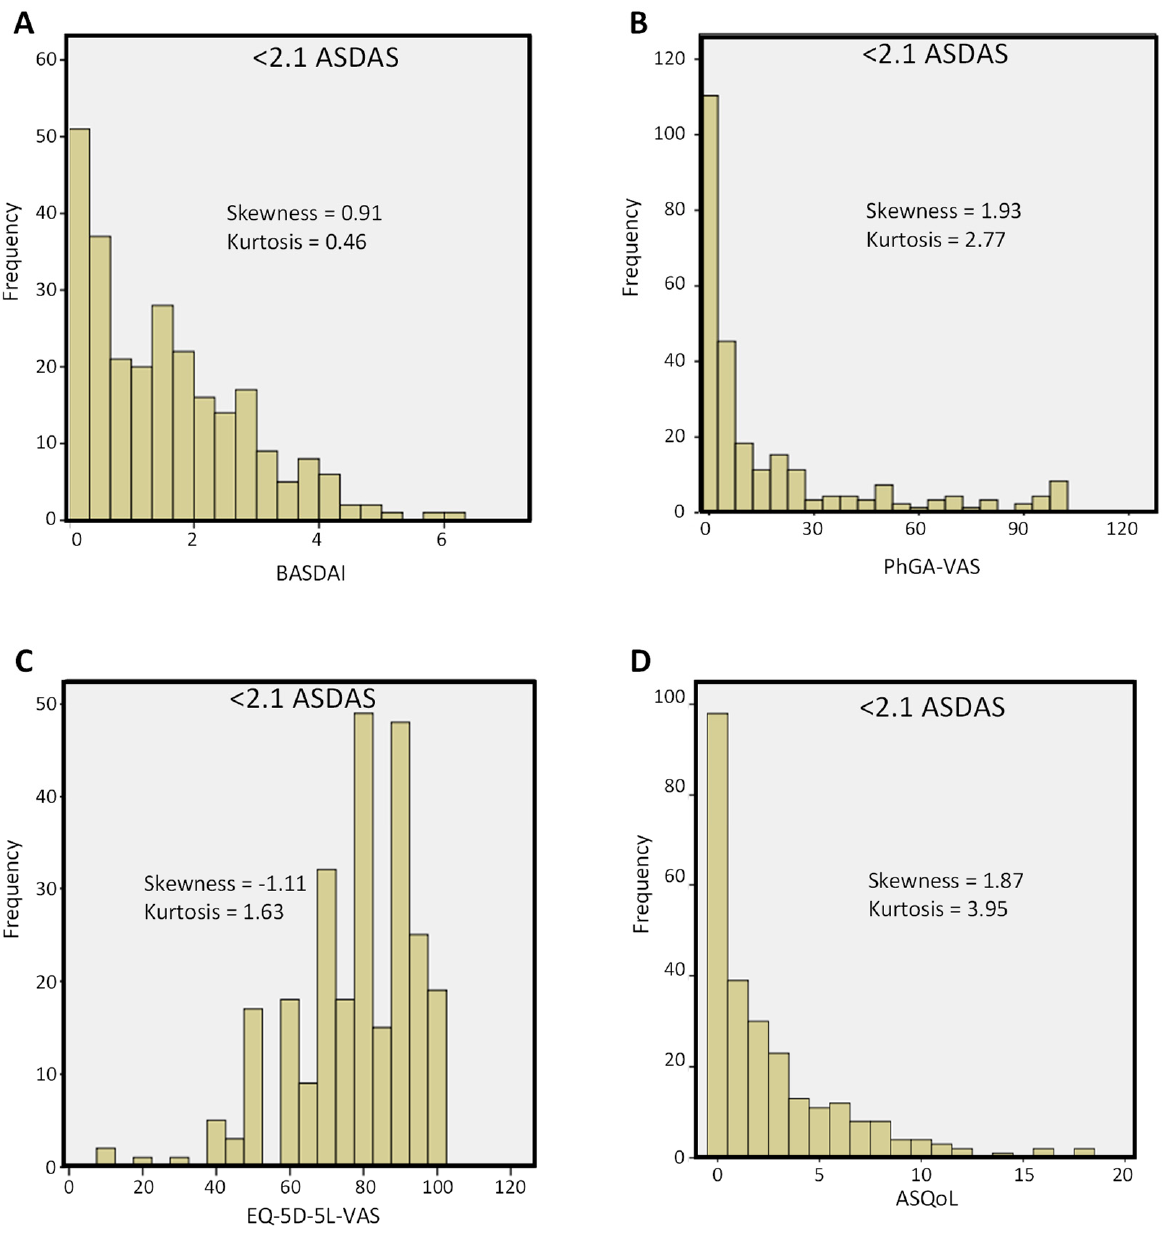
Figure 2. Frequency distribution of ( A ) BASDAI, ( B ) PhGA-VAS, ( C ) EQ-5D-5L-VAS, and ( D ) ASQoL scores in patients with axSpA in at least low disease activity state (ASDAS < 2.1). ASDAS = Ankylosing Spondylitis Disease Activity Score; ASQoL = Ankylosing Spondylitis Quality of Life; BASDAI = Bath Ankylosing Spondylitis Disease Activity Index; EQ-5D-5L-VAS = EuroQoL 5-Dimension 5-Level visual analogue scale component of EQ-5D-5L to describe the health status of the patient; PhGA-VAS = Physician Global Assessment-visual analogue scale.